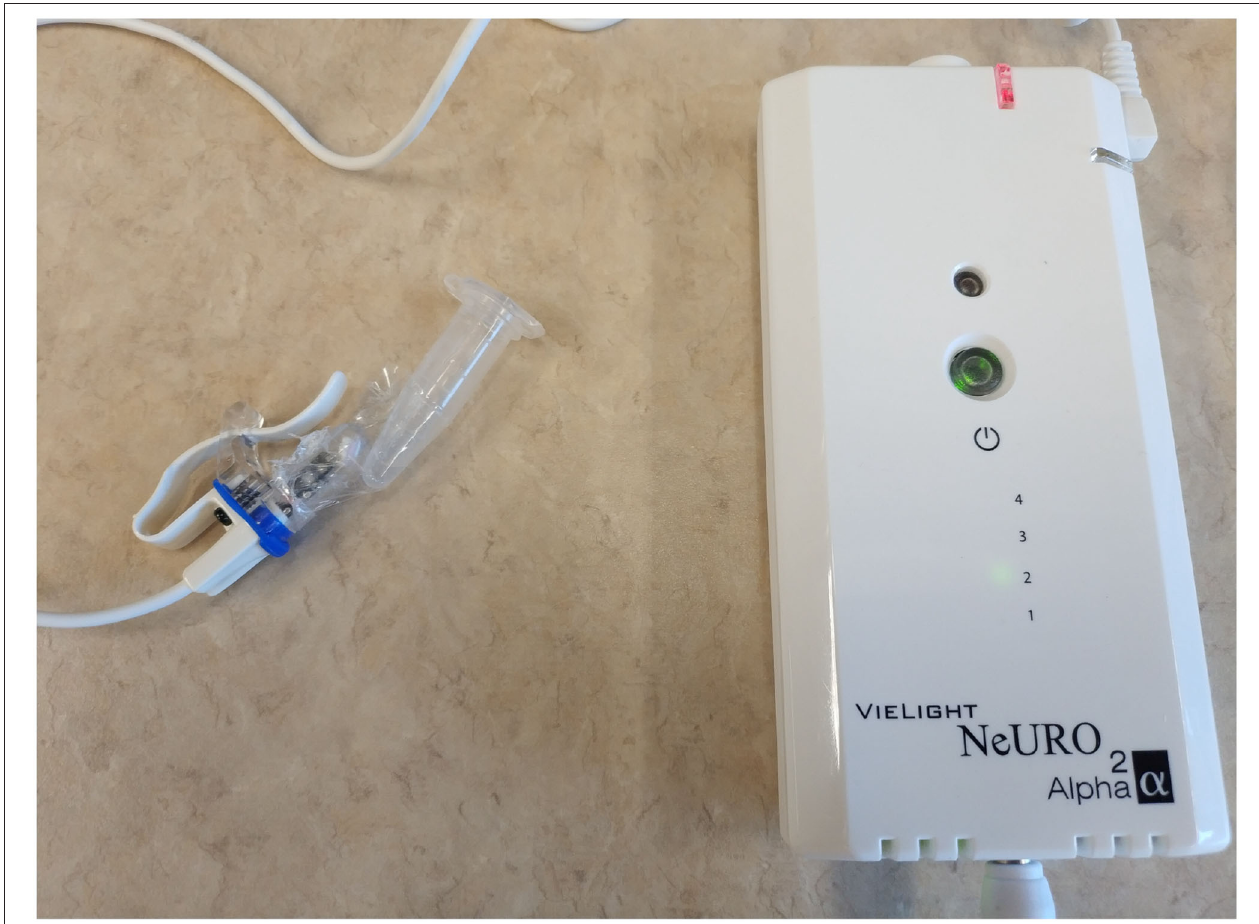
FIGURE 5 | A digital photograph of a sample aliquot of tubulin solution attached to the LED intranasal applicator of the Vielight Neuro Alpha device for PBM